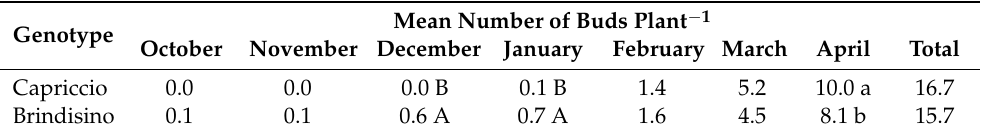
Table 6. Effects of genotypes on monthly bud yield 1 .